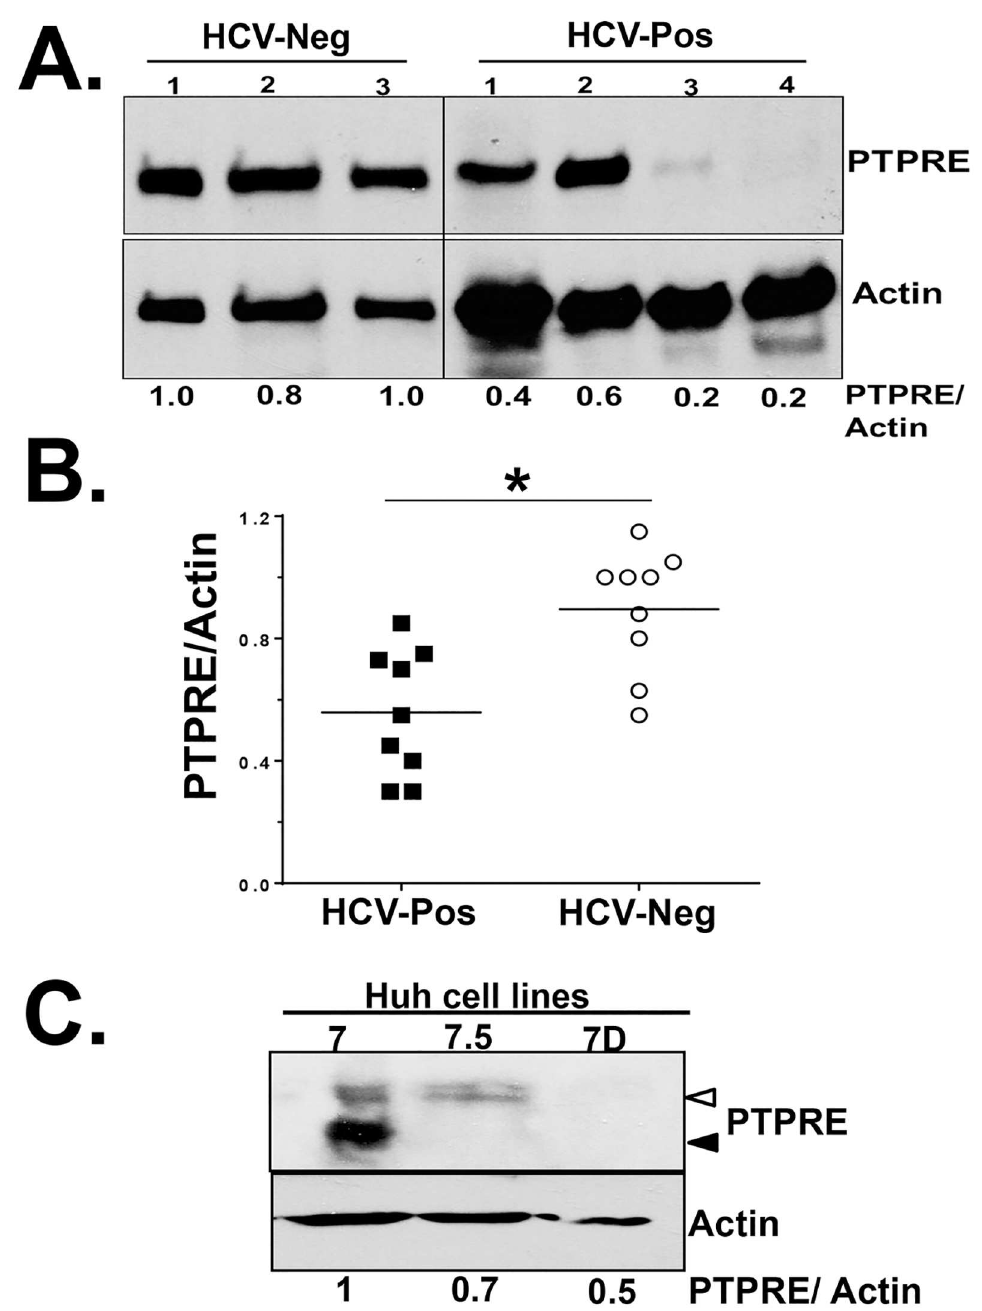
Fig 6. PTPRE expression is reduced in the liver of HCV-infected humans. PTPRE expressionin liver explanttissues obtainedfrom HCV-infected and uninfectedhumans with liver diseasewere determinedby immunoblot analysis(selected examplesin panel A). PTPRE levels relative to the actin loadingcontrol for all liver tissue samplesstudied (B). PTPRE levels in the Huh7 hepatomacell line and in two cell lines clonally selectedfrom Huh7 cells (Huh7.5and Huh7D). HCV replication is significantly greater in Huh7.5 and Huh7D comparedto Huh7 (C). Open arrow = PTPRE isoform 1 (transmembrane), Closedarrow = PTPRE isoform 2 (cytosolic). * P <